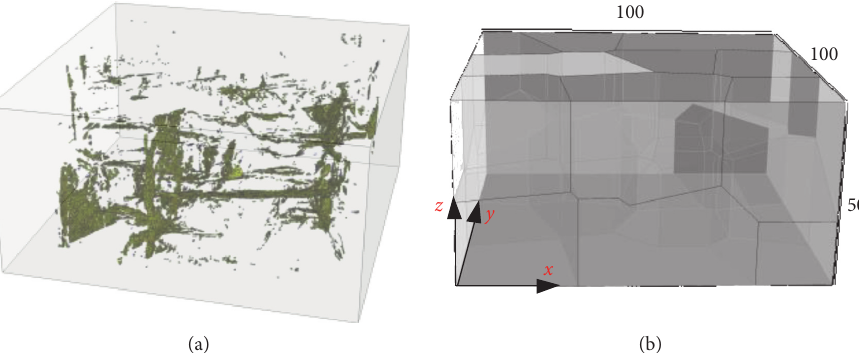
Figure 8: CTscanning and discontinuities network model of fractured coal. (a) Discontinuities in coal sample. (b) Reconstruction model of